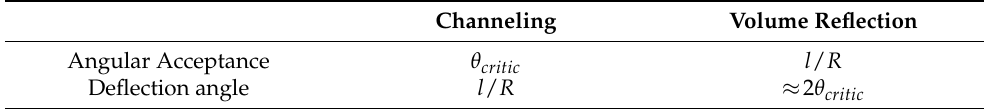
Table 1. θ critic is the planar channeling critical angle, l is the crystal length, R is the radius of